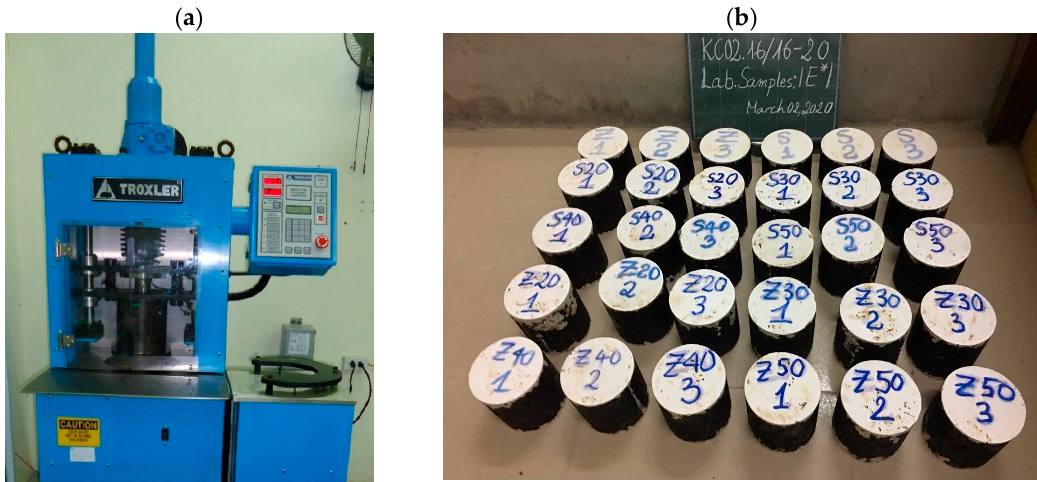
Figure 2. The sample preparation: ( a ) Compaction by Gyratory Compactor machine, ( b ) The testing samples.